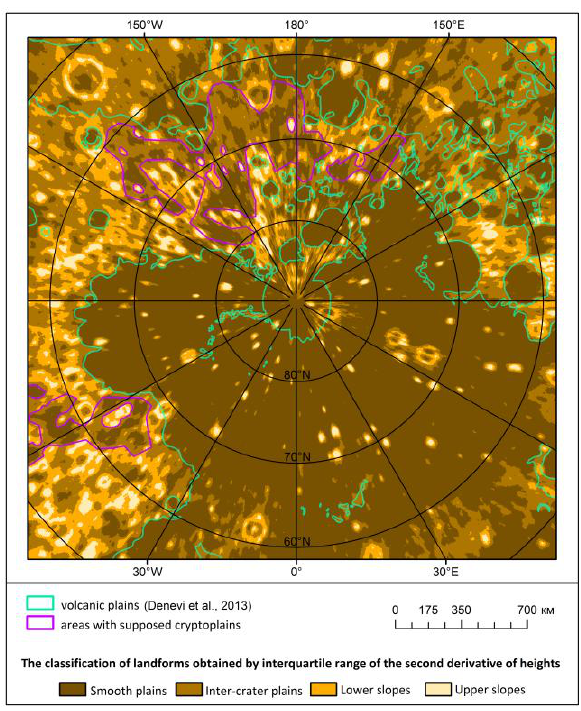
Figure 8. Map of the northern polar region of Mercury (projection: polar stereographic); classified values of IQR distinguish the smooth plains (turquoise) and areas of the supposed “cryptoplains”